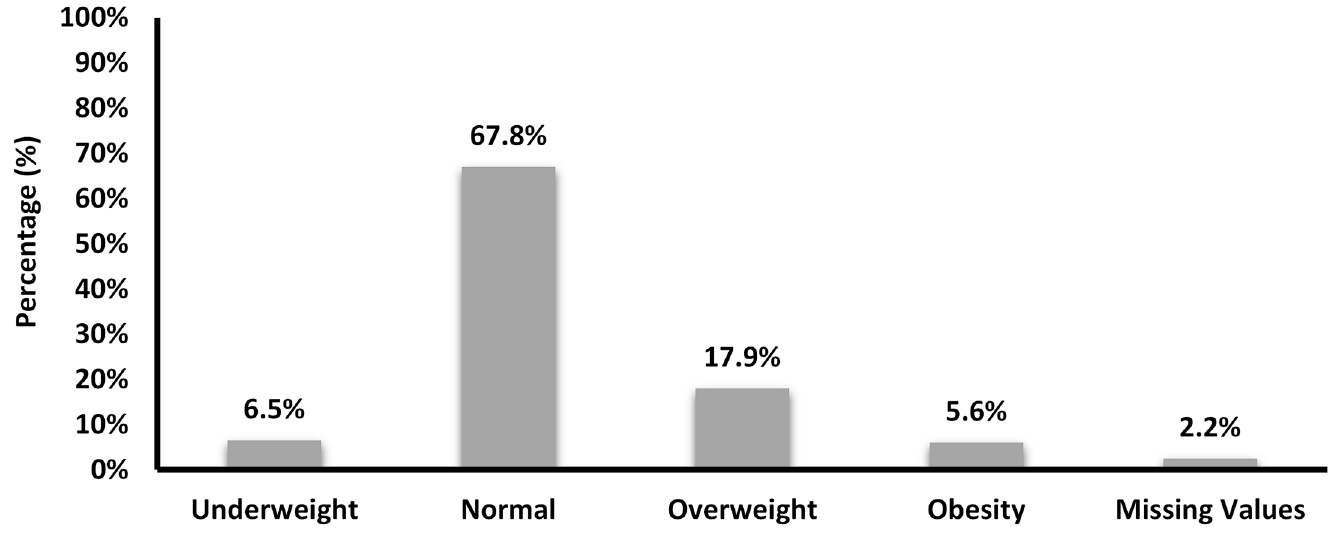
Fig 1. Distribution of mothers according to their pre-pregnancy BMI categories (N = 978).